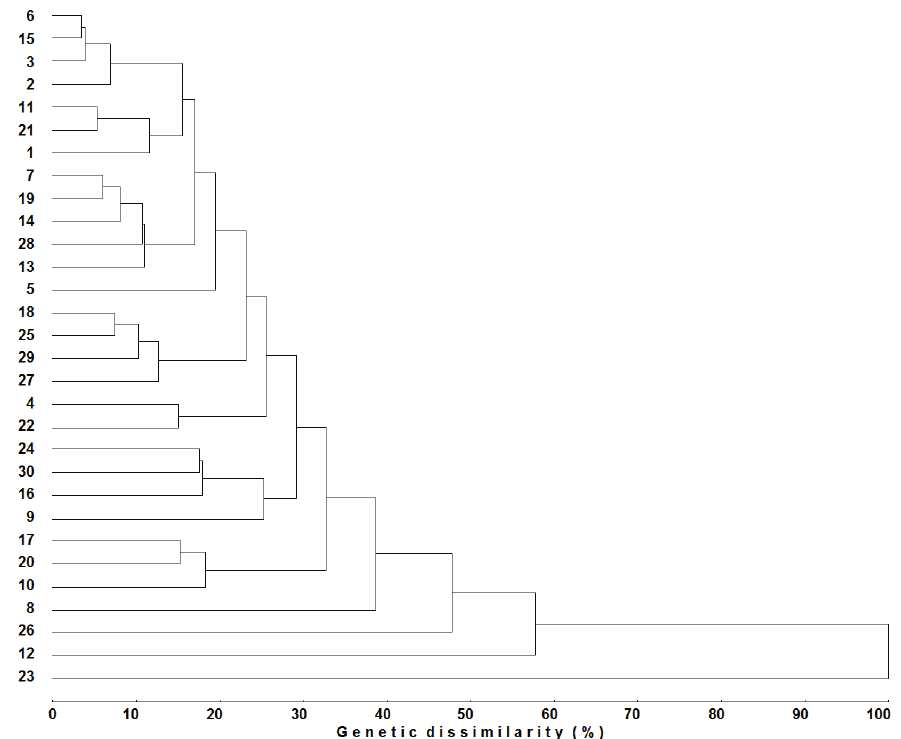
Figure 1 - Dendrogram representing the genetic dissimilarity among 30 promising registered Coffea canephora genotypes, obtained by the UPGMA cluster method, using generalized Mahalanobis distance (D 2 ), considering 15 morpho-agronomic traits. Note: cophenetic correlation coefficient (CCC):